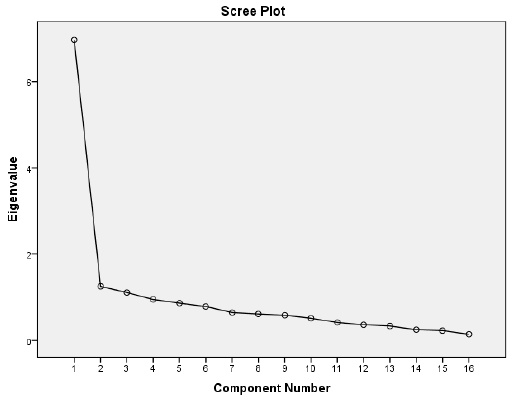
Figure 1. Scree Plot of eigenvalues for the original 16 items of the Starvation Symptom Inventory in the anorexia nervosa sample.